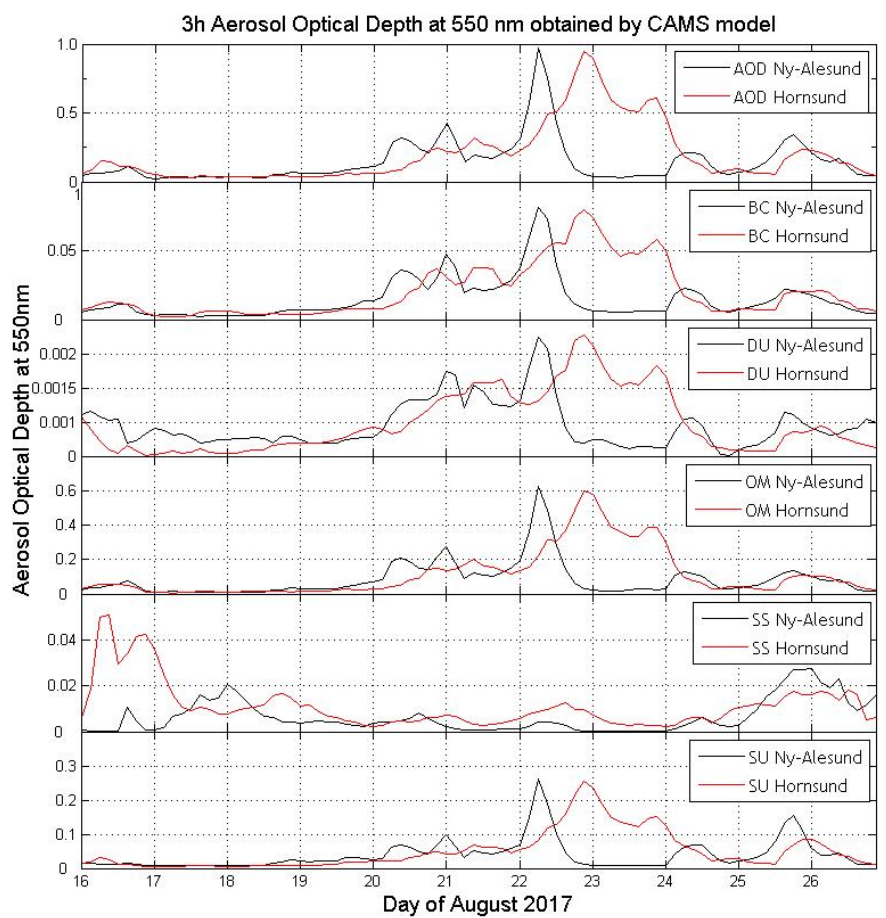
Figure 12. 3 h Aerosol Optical Depth at 550 nm and 5 chemical components of Aerosol Optical Depth at 550 nm: black Carbon (BC), dust (DU), organic matter (OM), sea salt (SS), and sulphate (SU) in Hornsund (red lines) and Ny-Ålesund (black lines) between 16 and 27 August 2017.